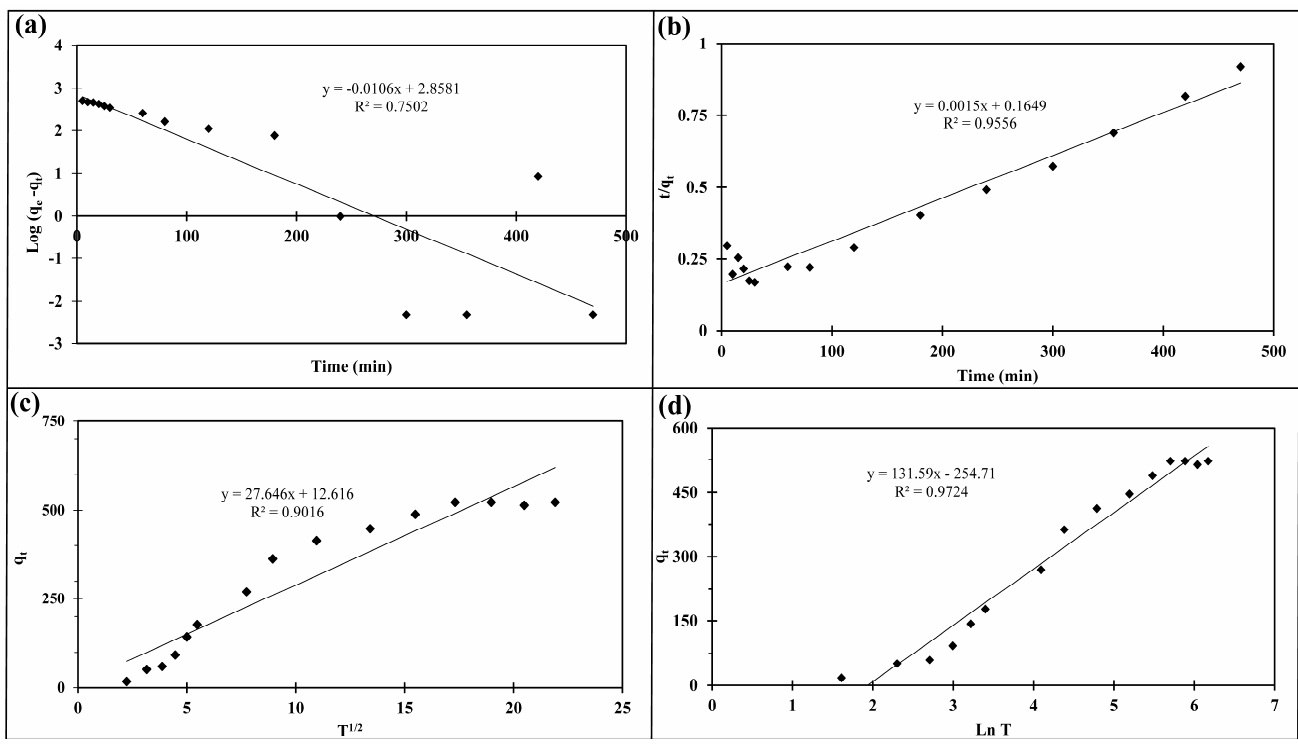
Figure 4. Kinetic study of heparin adsorption over ZIF-8 via ( a ) pseudo-first-order, ( b ) pseudo-second-order, ( c ) intraparticle diffusion, and ( d ) Elovich models. Table 1. Calculated parameters from different kinetic study models of heparin adsorption over ZIF- 8.